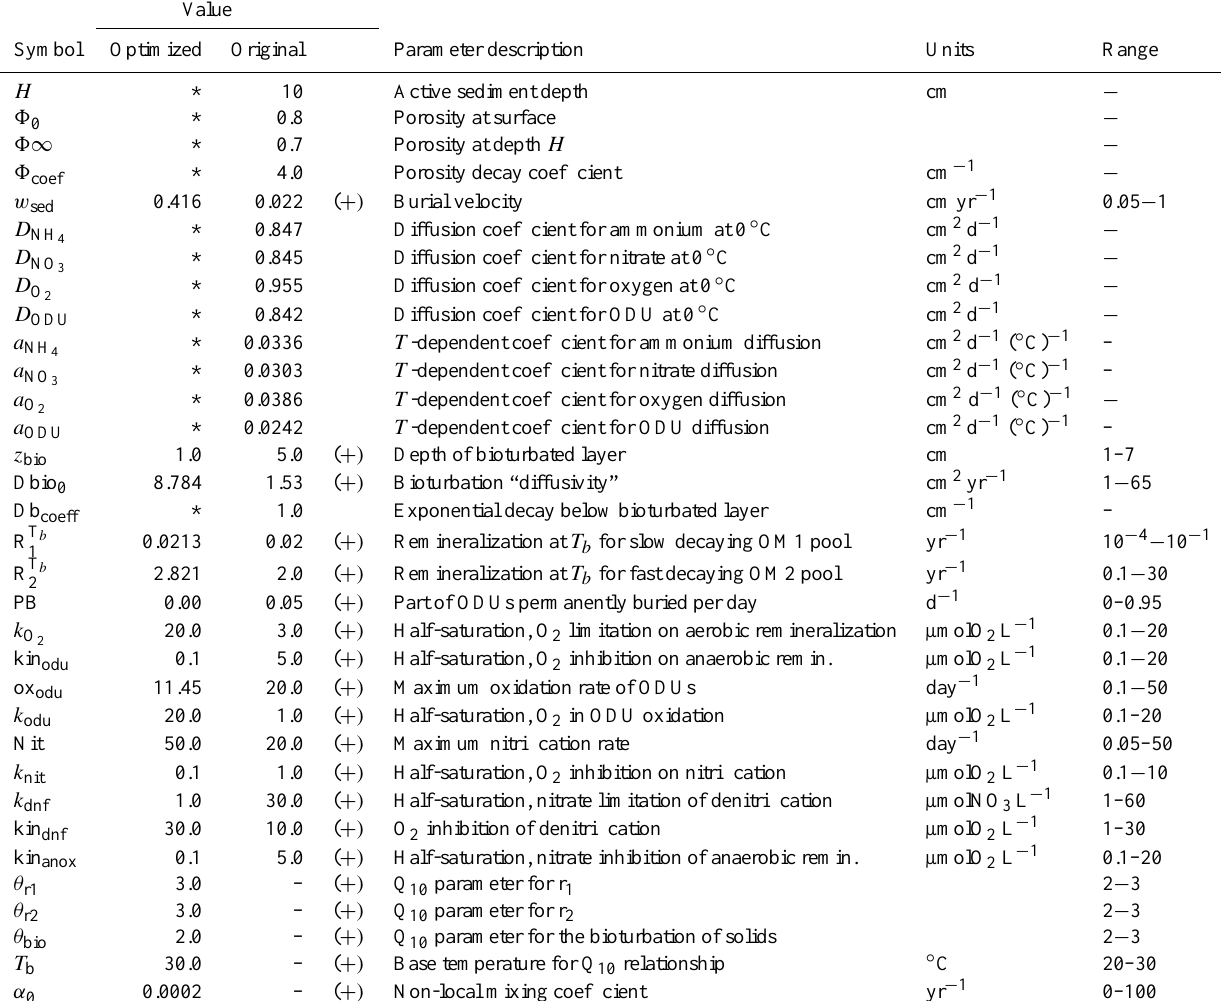
Table 2. Diagenetic model parameters. The 20 parameters that were optimized are indicated with a + sign. The original values are from Soetaert et al. (1996a); an asterisk indicates values that are identical in the optimized parameter